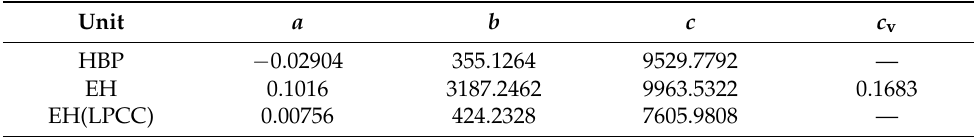
Table 2. Unit coal consumption